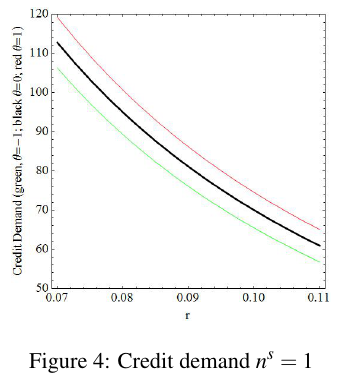
Figure 4: Credit demand n s = 1 (black → ε = 0 , red → ε > 0 , green → ε < 0